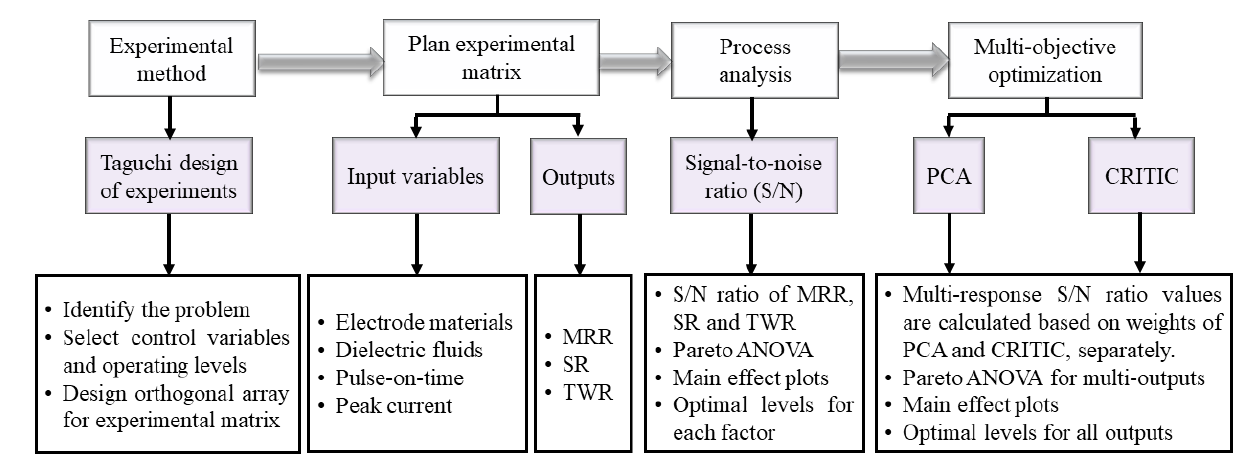
Figure 1. Framework of proposed research work.